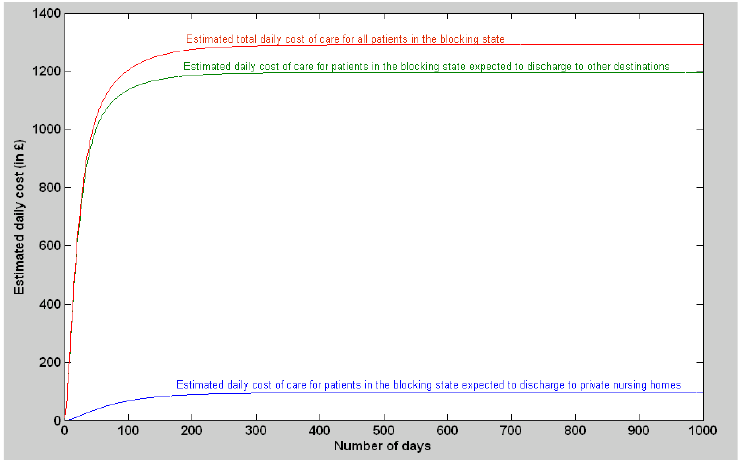
Figure 15. The estimated daily cost of care for patients in the blocking state of each phase (for mean discharge delay τ = 10 days).